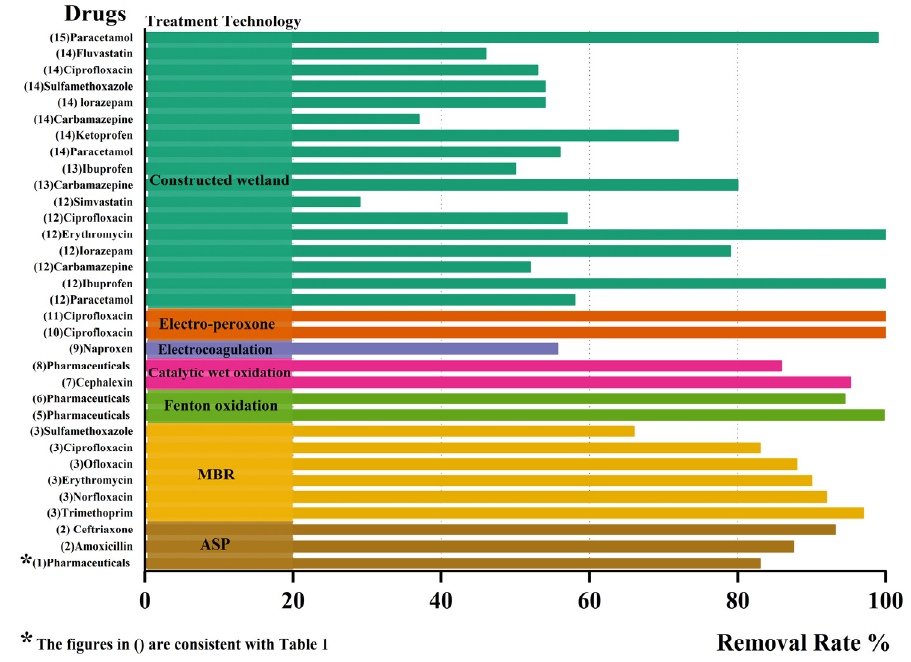
Figure 4. Various treatment processes’ rates of drug removal from hospital